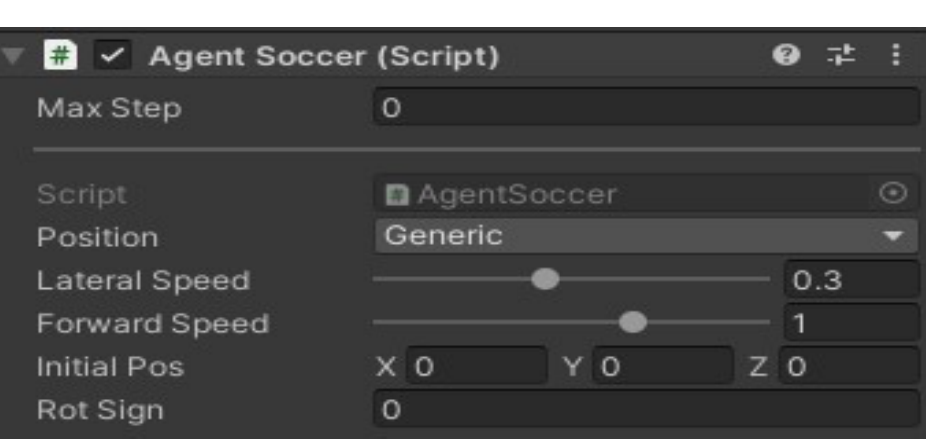
Figure 6. AI agent - player’s position—defender (generic).